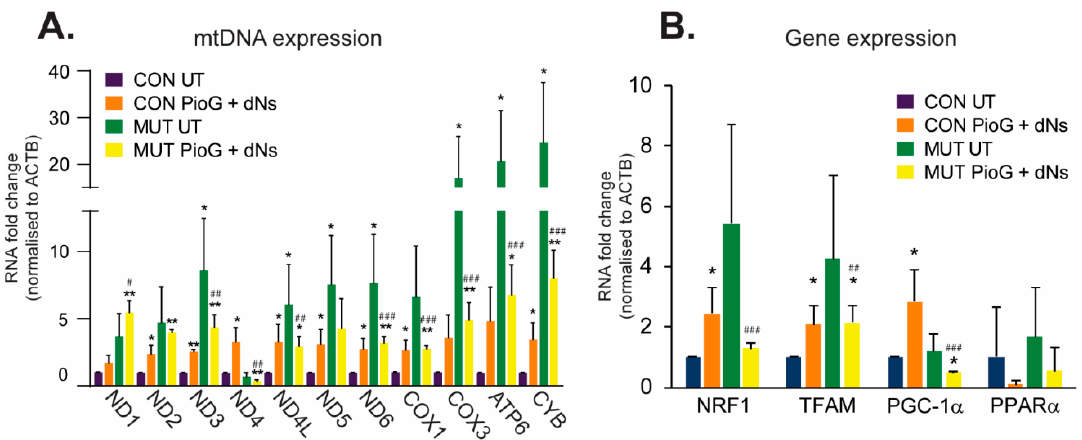
Figure 2. Effect of seven days of PioG + dNs combination treatment on gene expression in control (CON) cybrids and m.3243A>G (MUT) cybrids. ( A ) Expression of mtDNA-encoded transcripts was higher in untreated MUT cybrids compared to untreated CON cybrids. PioG + dNs treatment increased expression in CON cybrids, but reduced expression in MUT cybrids. ( B ) Expression of nuclear-encoded genes associated with mitochondrial biogenesis was increased in CON cybrids following PioG + dNs treatment, but was decreased in MUT cybrids. UT = untreated; values shown are mean ± s.d. * p < 0.05, ** p < 0.01, relative to untreated CON values; # p < 0.05, ## p < 0.01, ### p < 0.001 relative to untreated MUT values (Student’s t -tests).